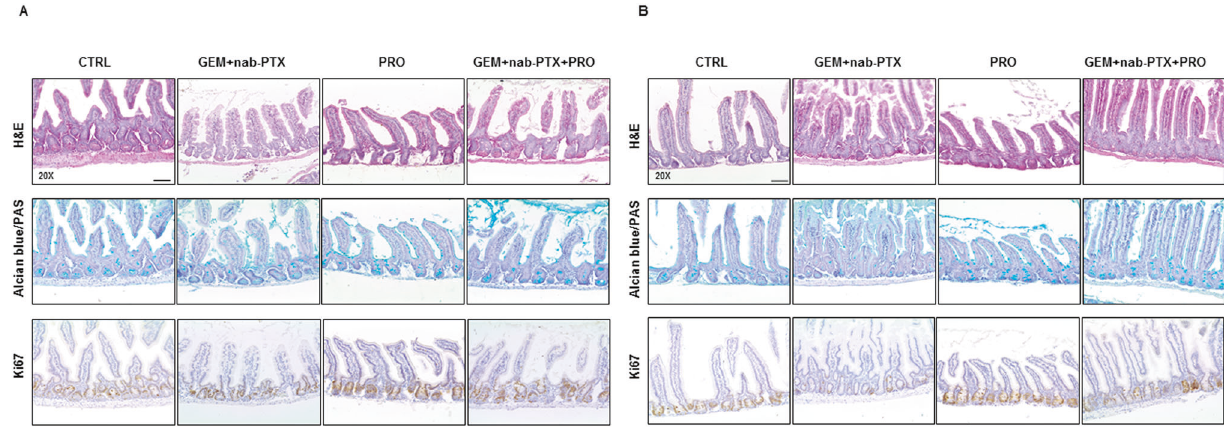
Fig. 4 Role of chemotherapy and/or probiotic treatment on murine small intestine architecture. Representative pictures of hematoxylin/ eosin, Alcian Blue/PAS and Ki67 in BxPC-3 ( A ) and PANC-1 ( B ) small intestine sections (×20 magni fi cation). Scale bar 50